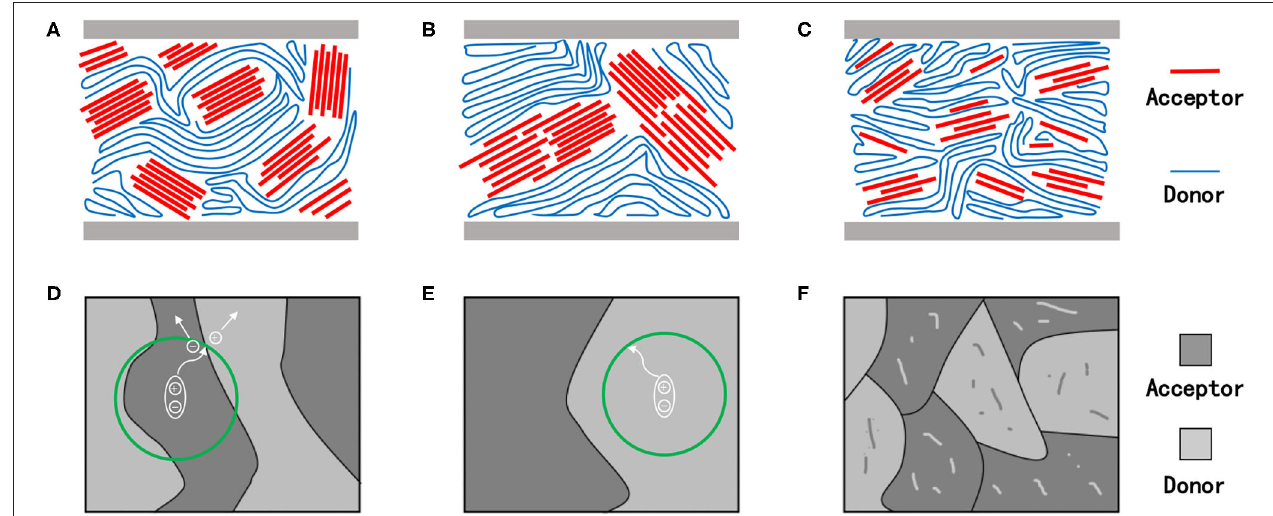
FIGURE 2 | Schematic diagram of molecular stacking (A–C) , charge transfer and separation in the film (D–F) with suitable (A,D) , too strong (B,E) , and too weak (C,F) crystallinity. The green circle represents the range of electron-hole pairs transporting in organic semiconductor materials.